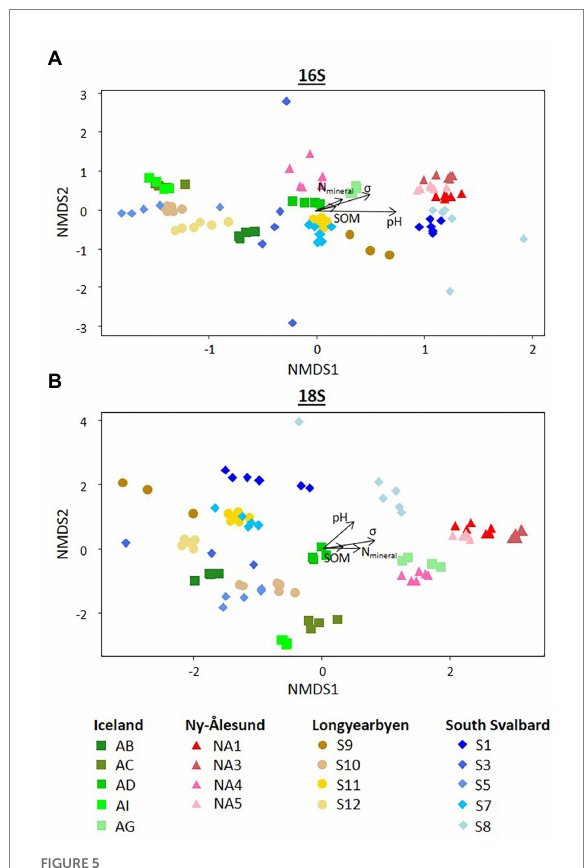
FIGURE 5 Non-metric multidimensional scaling (NMDS) plots based on the ASVs abundance (number of reads) of (A) 16S and (B) 18S rRNA genes. Arrows indicate significant correlations ( p < 0.05) with environmental variables. SOM soil organic matter, N min – mineral nitrogen, σ – conductivity.